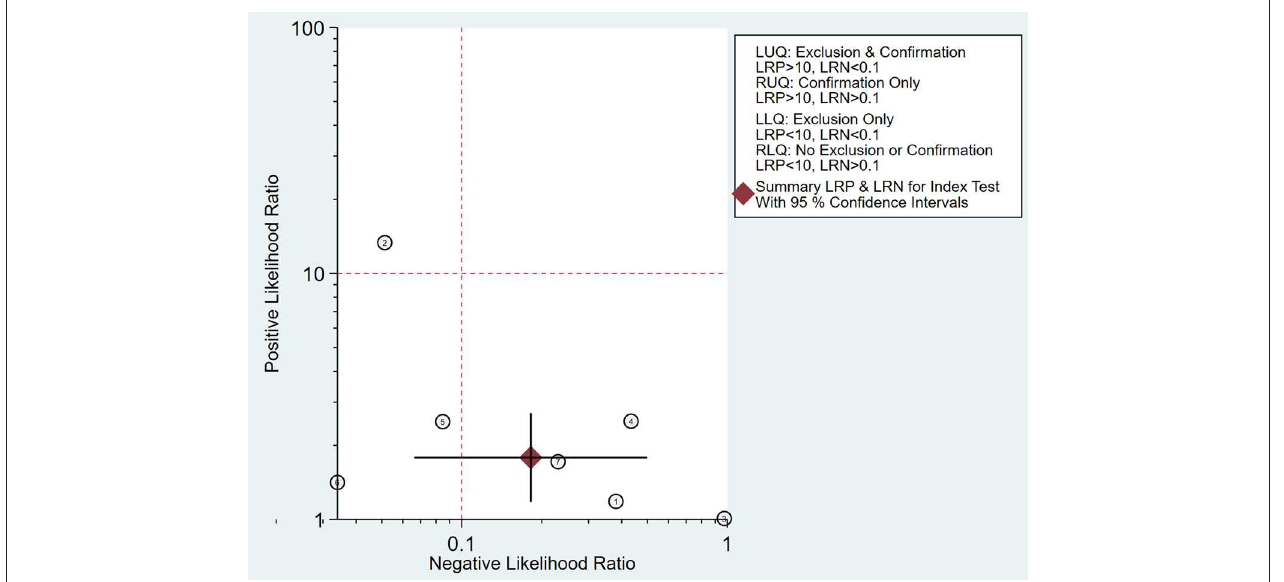
FIGURE 8 | Likelihood matrix indicates that summary positive likelihood ratio (PLR) and negative likelihood ratio (NLR) for micro-ultrasound diagnosis of clinically significant prostate cancer (csPCa) with 95% confidence intervals are concentrated on the right lower quadrant